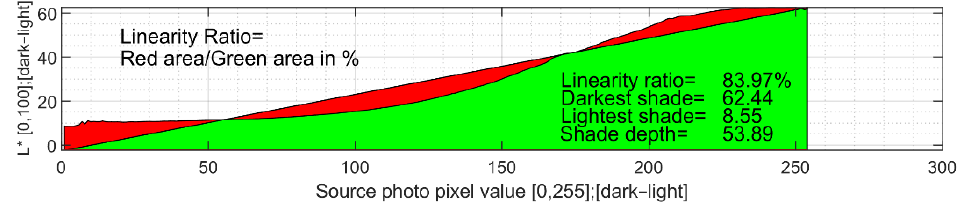
Figure 12. Linearity of shade dependence evaluation.